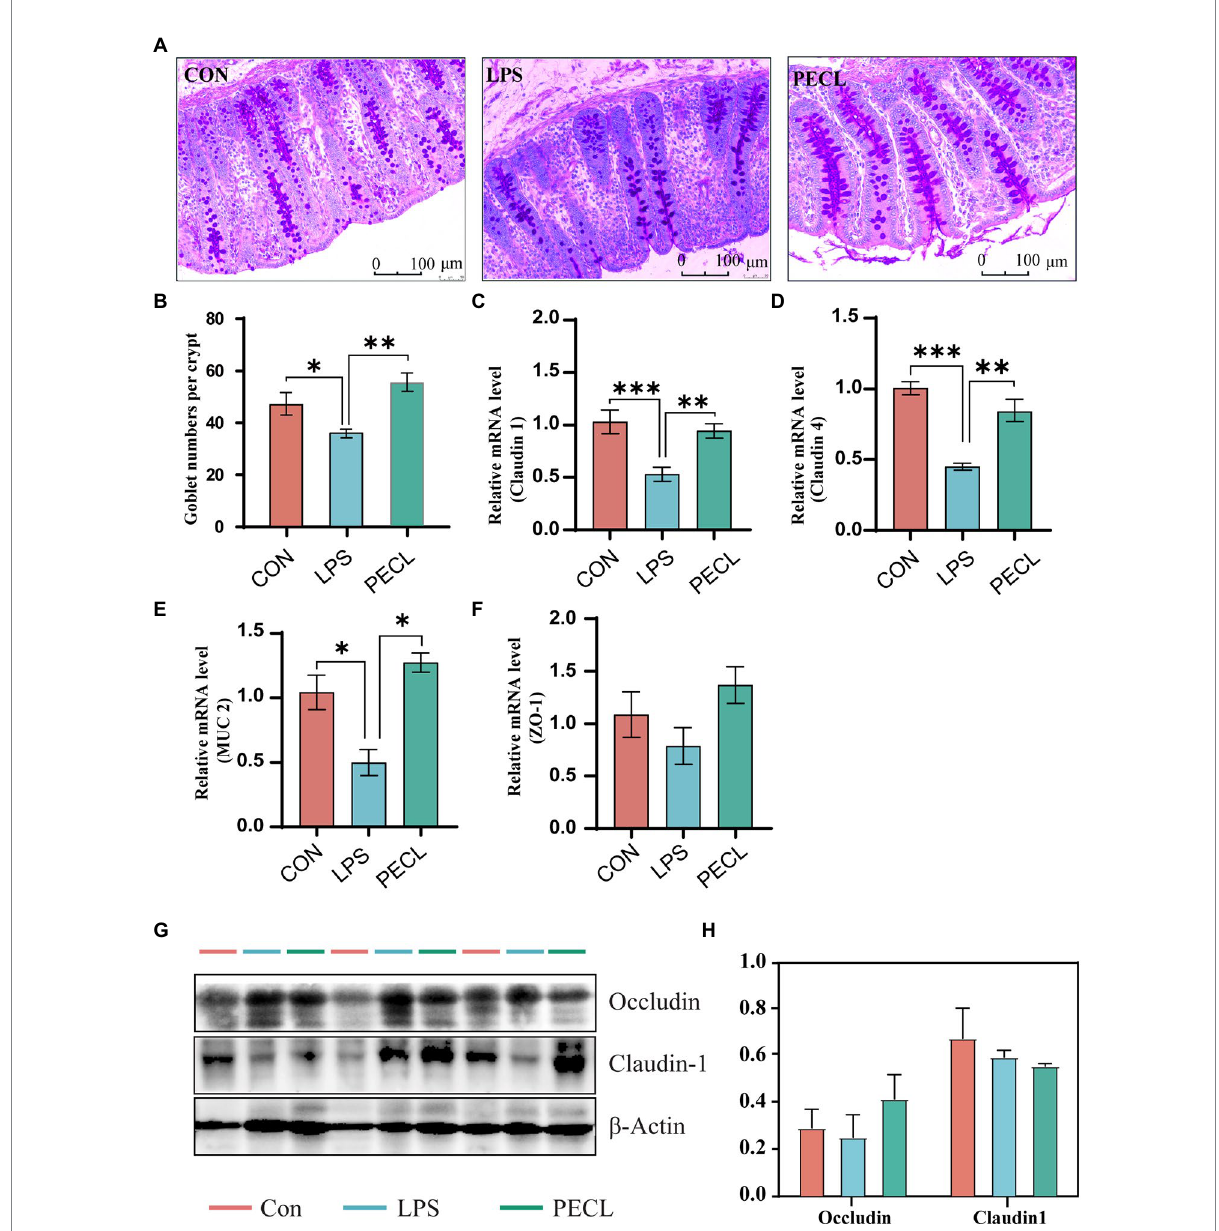
FIGURE. 1 Effects of dietary supplemented with pectin on gut morphology of LPS challenged piglets. (A) Representative PAS-stained cecum sections. (B) Goblet number. The fold change in mRNA expression relative to β -actin for (C) Claudin-1 , (D) Claudin-4 , (E) ZO-1 , (F) Muc-2 is shown. And (G,H) Western blot analysis of Occludin and Claudin1. Signification is presented as * p < 0.05, ** p < 0.01, and *** p < 0.001; data are presented as the mean ± SE (mRNA, n = 8; WB, n =